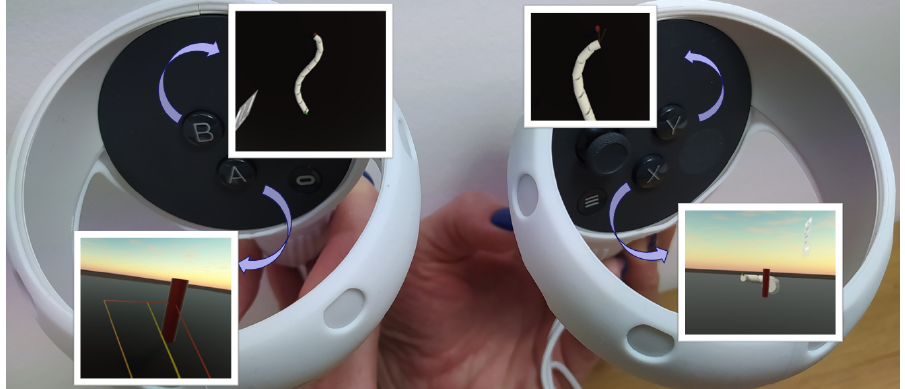
Figure 4. Oculus Quest 2 controllers with buttons changing the camera